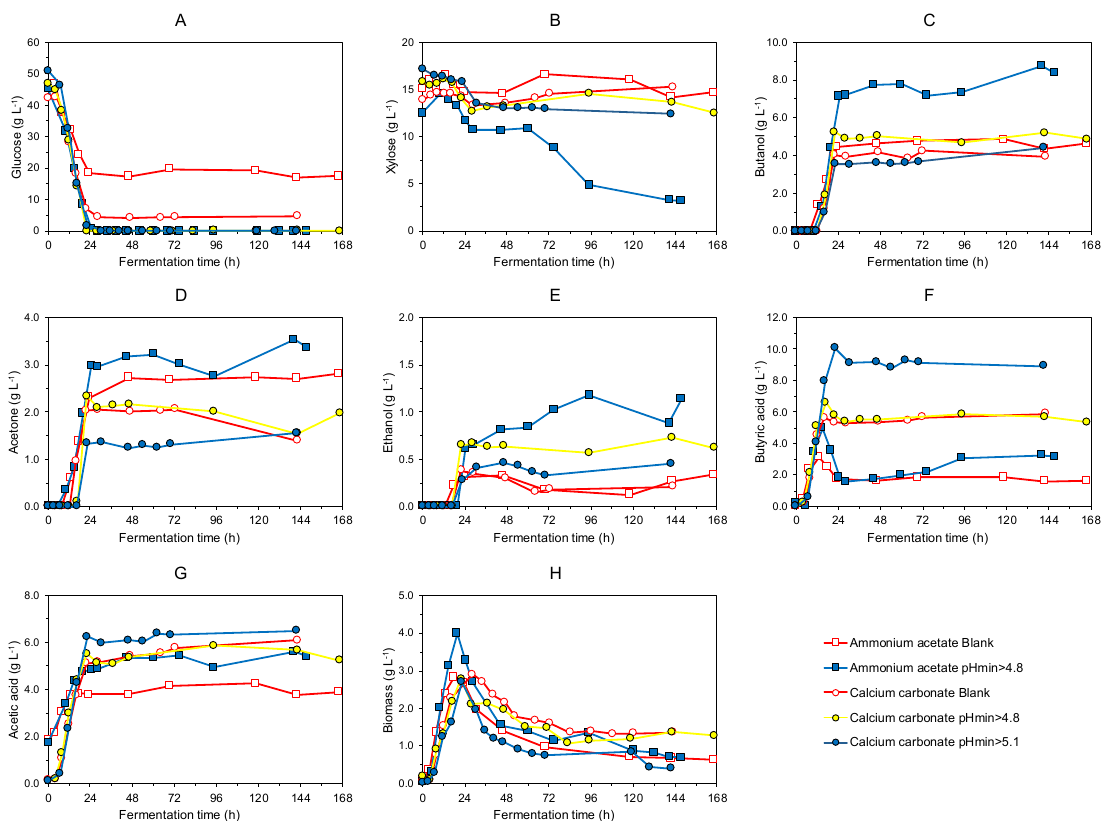
Figure 4. Fermentation profiles of ( A ) glucose, ( B ) xylose ( C ) butanol, ( D ) acetone, ( E ) ethanol, ( F ) butyric acid, ( G ) acetic acid and ( H ) biomass in g L − 1 with C. acetobutylicum with 3:1 glucose/xylose ratio in batch mode.